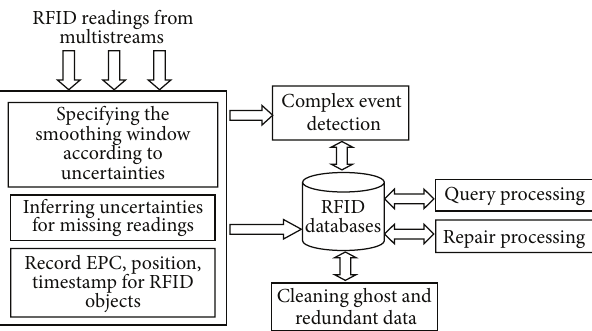
Figure 2: A system view of our proposed framework to process RFID